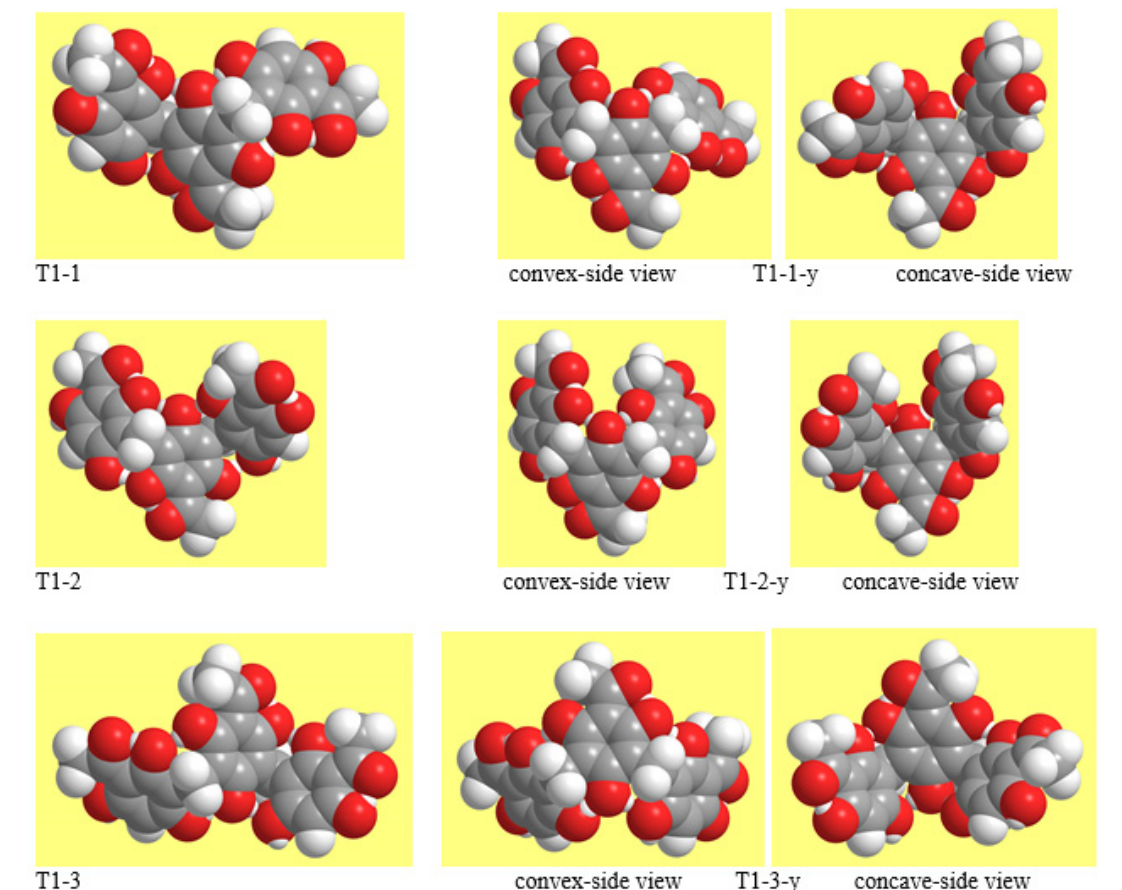
Figure 5. Effect of the monomers’ mutual orientation on the conformer geometry. In T1-1, two consecutive monomers are oriented in the same way (up—down—down orientation). In T1-2, the orientations of the monomers are alternate (up—down—up orientation). In T1-3, the monomers are oriented in the same way (up—up—up orientation). Space-filling models are used to better highlight the mutual orientations of the planes of the three benzene rings.